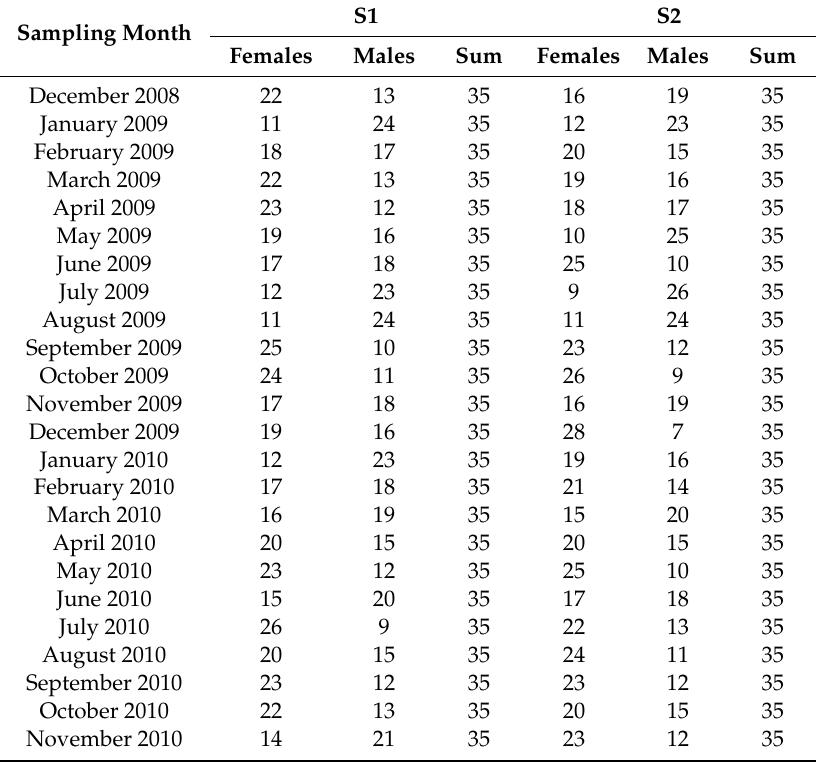
Table 1. Number of Paracentrotus lividus female and male specimens per sampling month at the two sampling stations (S1 and S2) in the Pagasitikos